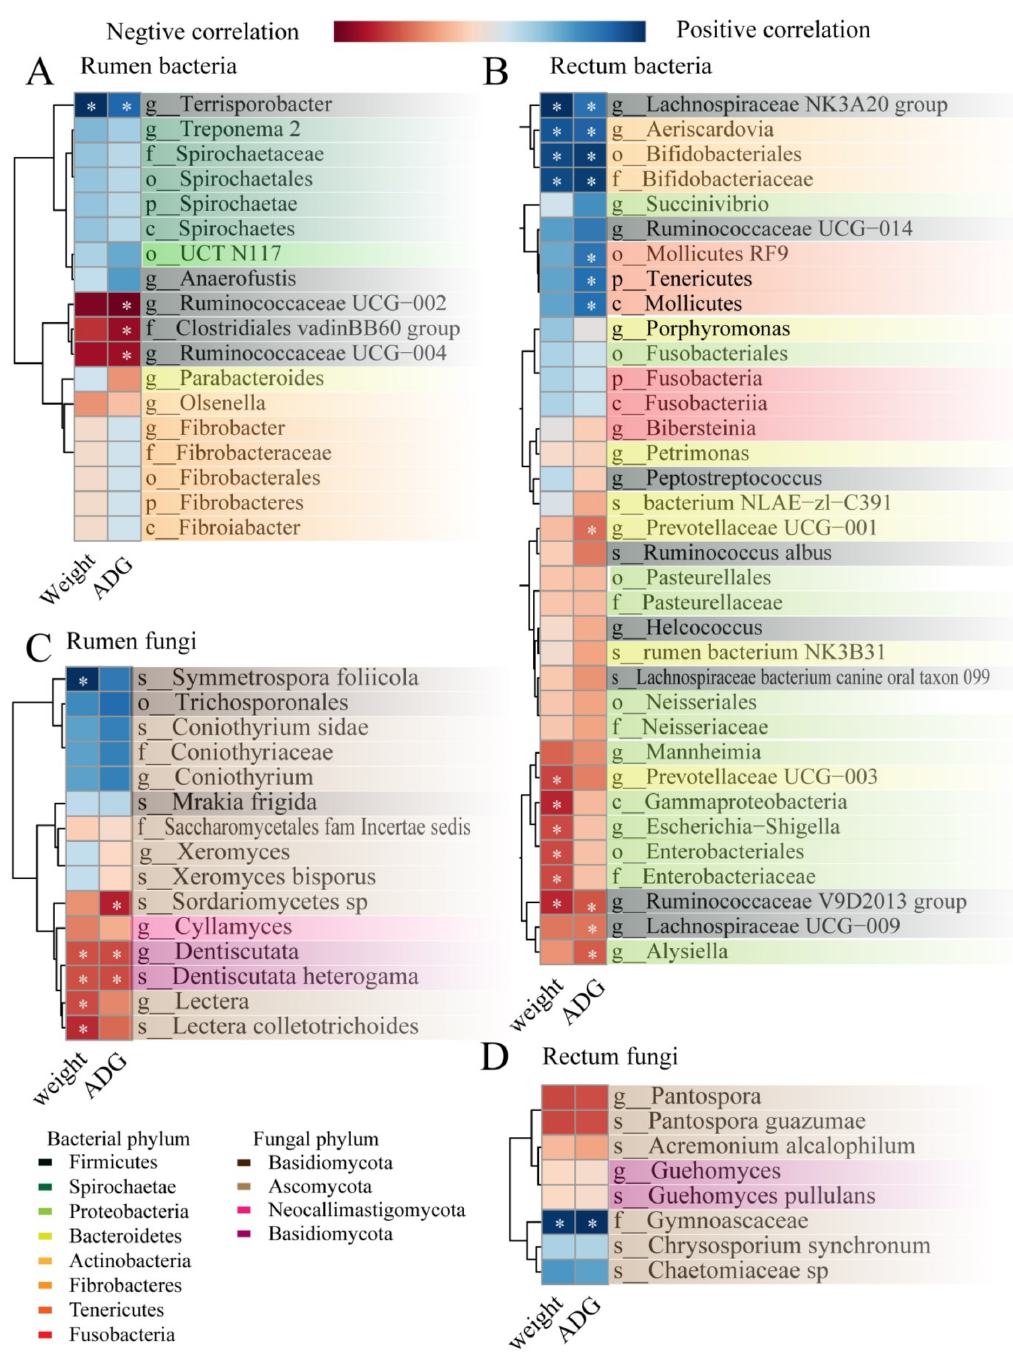
Figure 8. Heatmap of biomarkers (identified by LefSe analysis between the five lambs with the lower average daily gain (LG) and the five lambs with the higher average daily gain (HG) in Figures 6 and 7, significantly associated with growth performance and average daily gain as determined by Spear- man’s correlation analysis in the ( A ) rumen bacterial community, ( B ) rectum bacterial community, ( C ) rumen fungal community, and ( D ) rectum fungal community. * p <